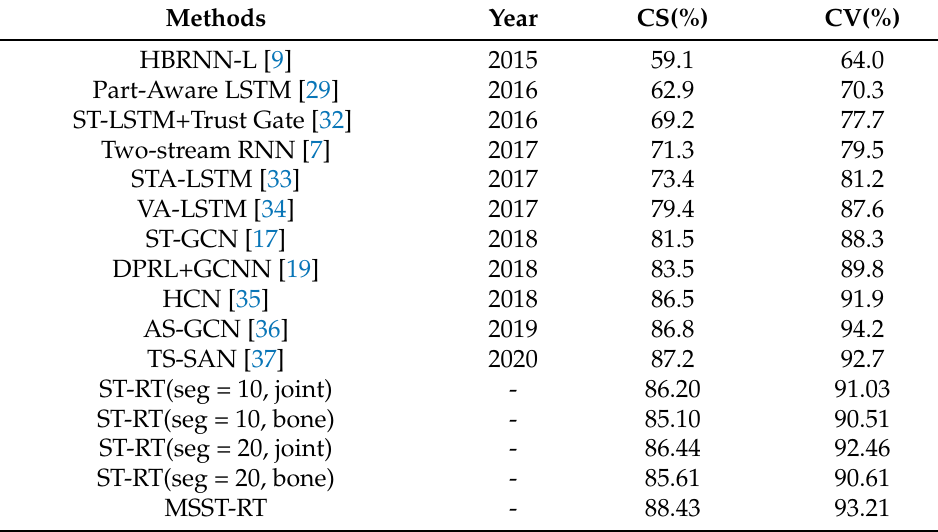
Table 1. Performance comparison on NTU